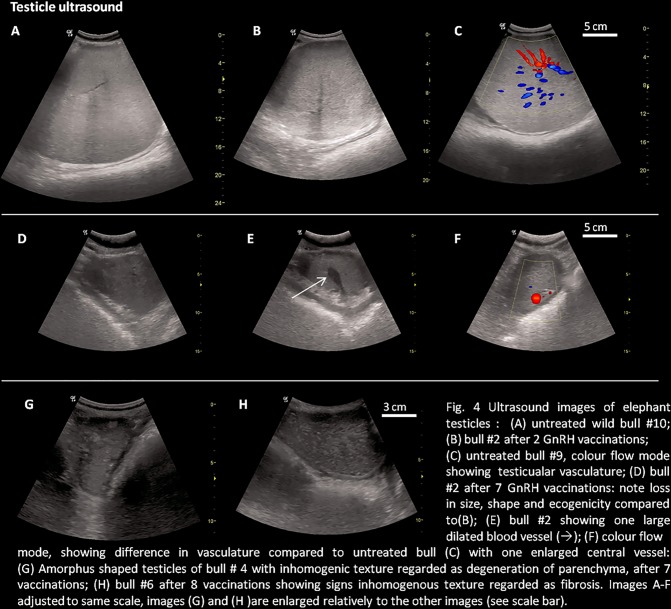
Ultrasonographic images of elephant bull testicles before and after GnRH vaccination: (A) untreated wild bull #10; (B) bull #2 after 2 GnRH vaccinations; (C) untreated bull #9, CD mode showing testicular vasculature; (D) bull #2 after 7 GnRH vaccinations: note loss in size, shape and ecogenicity compared to(B); (E) same bull #2 showing one large dilated blood vessel (→); (F) CD mode showing difference in vasculature compared to untreated bull (C) with one enlarged central vessel: (G) Amorphus shaped testicles of bull # 4 with inhomogenous texture regarded as degeneration of parenchyma, after 7 vaccinations; (H) bull #6 after 8 vaccinations showing signs inhomogenous texture regarded as fibrosis. Images A-F adjusted to same scale, images (G) and (H) are enlarged relatively to the other images (see scale bar); CD = Colour Doppler.